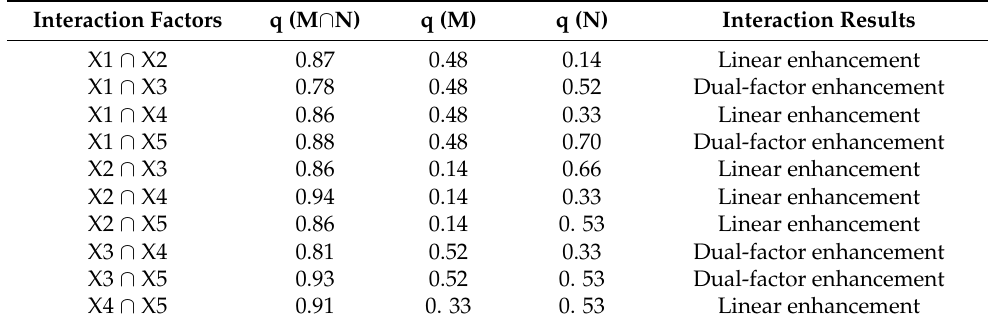
Table 7. Results of dual-factor